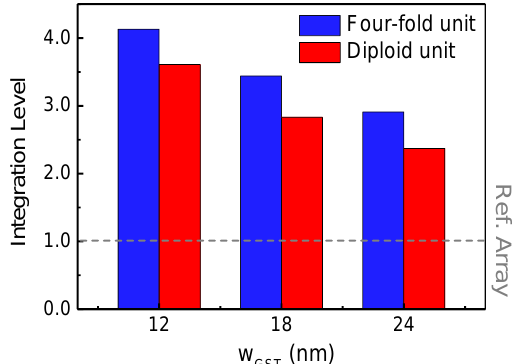
Figure 16. Integration density of vertical PCM arrays with diploid and four-fold units referred to the conventional vertical PCM array in [22] as functions of 𝑤 GST .